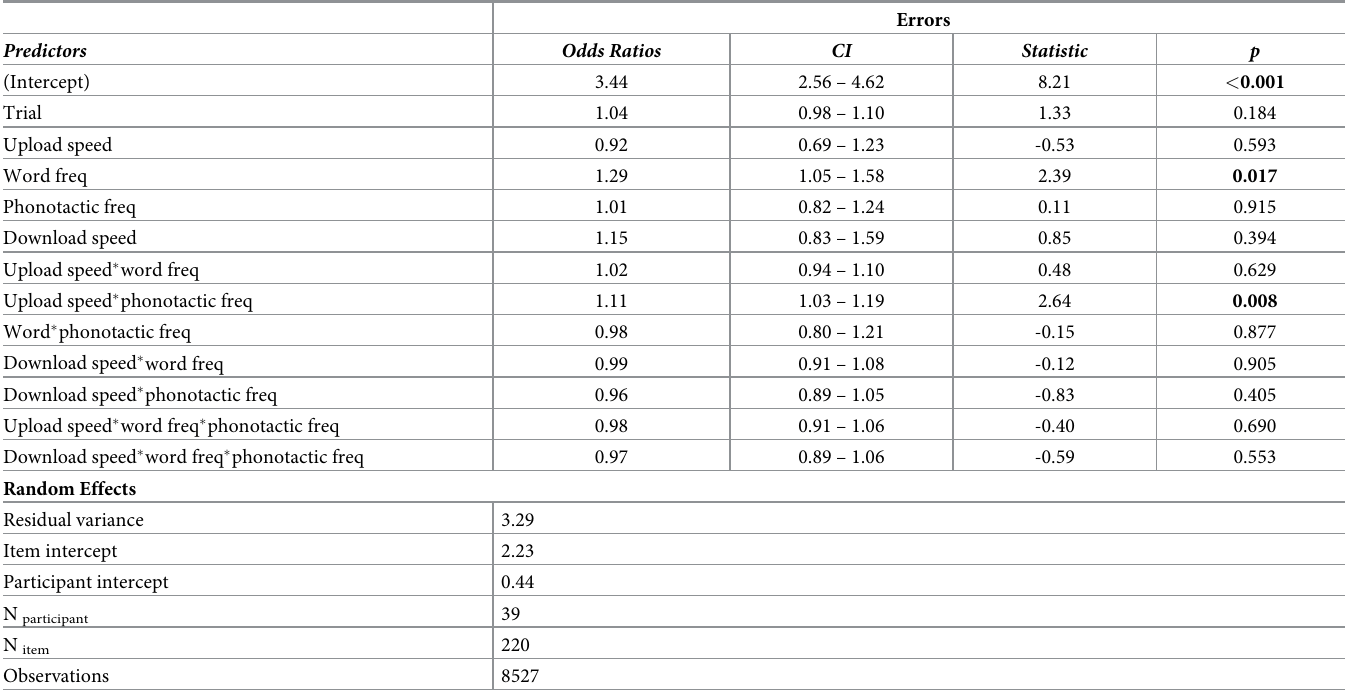
Table 6. Generalised linear mixed model output on error proportions.